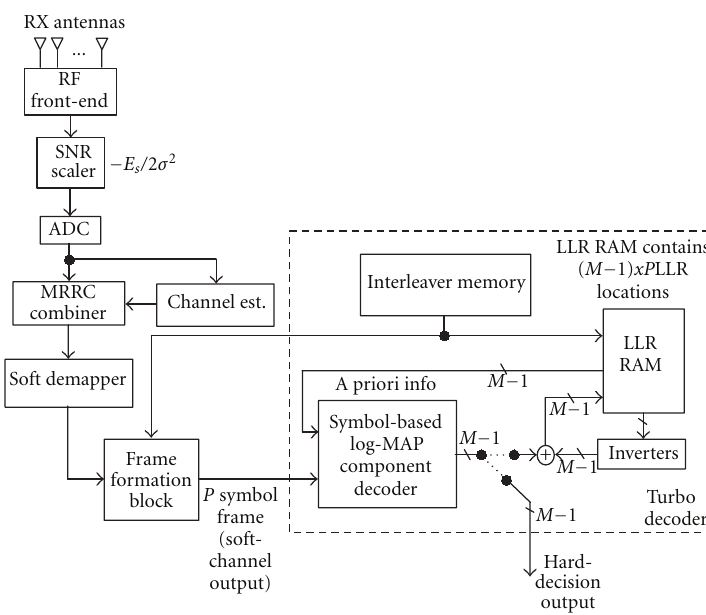
Figure 1: VLSI architectural model of STTuTC